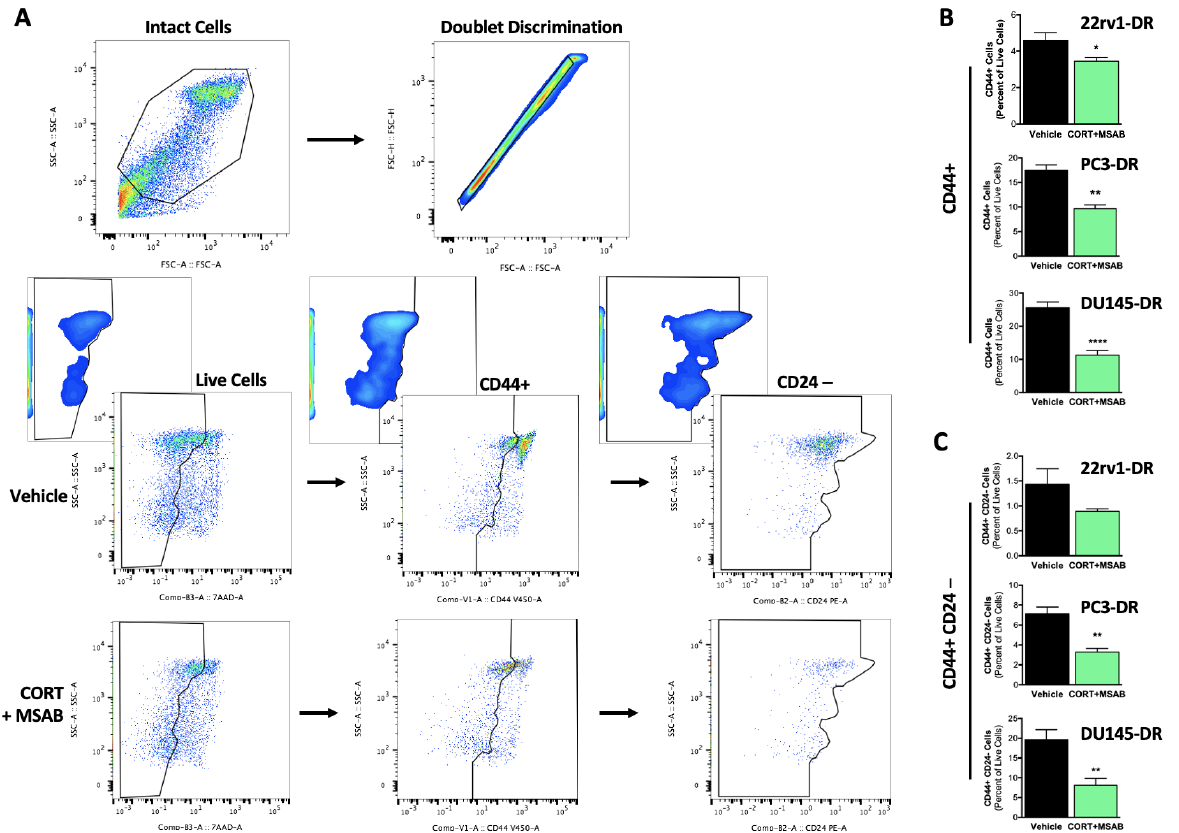
Figure 10. Co-inhibition of GR and β -catenin reduces the percent of cells with stemness markers in docetaxel-resistant tumorspheres. ( A ) Post-acquisition gating strategy, shown in a representative PC3-DR analysis. Data are depicted as pseudo color plots that denote population densities (high: red/orange, intermediate: yellow, low: blue/green) in bivariate settings (X-Y plane). The color densities do not refer to the spectral emission of the cells depicted, but rather the density of cells relative to one another. Doublet discrimination and fluorescence-minus-one controls (graph insets) are depicted with smoothing to better visualize the gating strategy. ( B ) CD44+ expression presented as percent of live (7AAD-negative) cells staining positive for CD44 in 22rv1-DR, PC3-DR, and DU145-DR cells from tumorspheres treated with CORT-108297 plus MSAB (CORT + MSAB, 1 µ M each) compared to vehicle (DMSO) control. ( C ) CD44+ CD24– expression presented as percent of live cells staining positive for CD44 and negative for CD24 in 22rv1-DR, PC3-DR, and DU145-DR cells from tumorspheres treated with CORT-108297 plus MSAB (CORT + MSAB, 1 µ M each) compared with vehicle control. Data are representative from 3 independent experiments and are represented as mean ± SEM. * p < 0.05, ** p < 0.01, **** p < 0.0001.